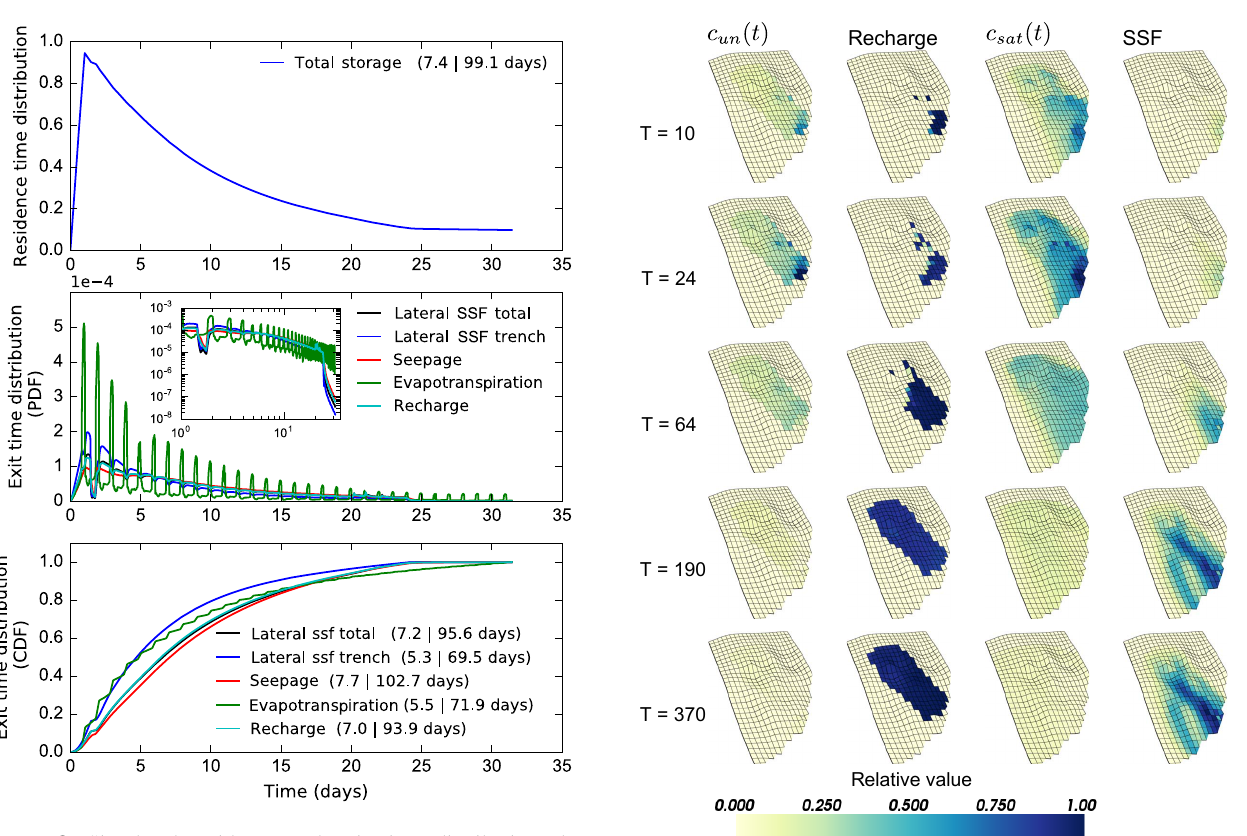
Figure 8. Simulated residence and exit time distributions by Model 2. The values between parentheses refer to median residence or median travel times. The first value between parentheses refers to the actual days (of the field experiment); the second value refers to the amount of days based on the average daily rainfall amount for this site (natural conditions).